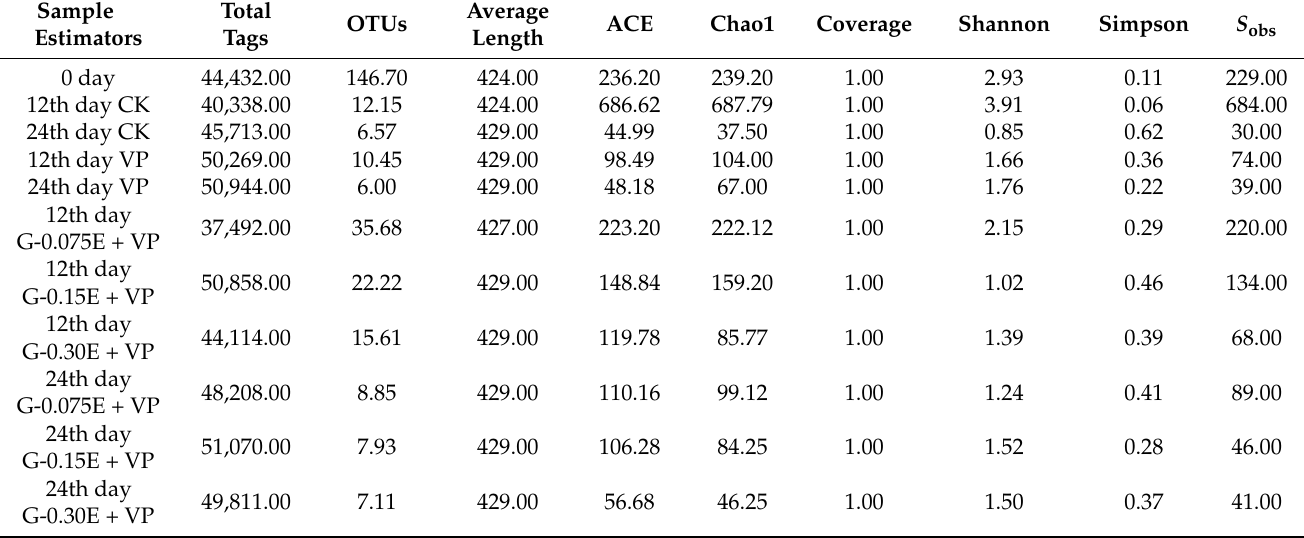
Table 2. Alpha diversity estimation of each